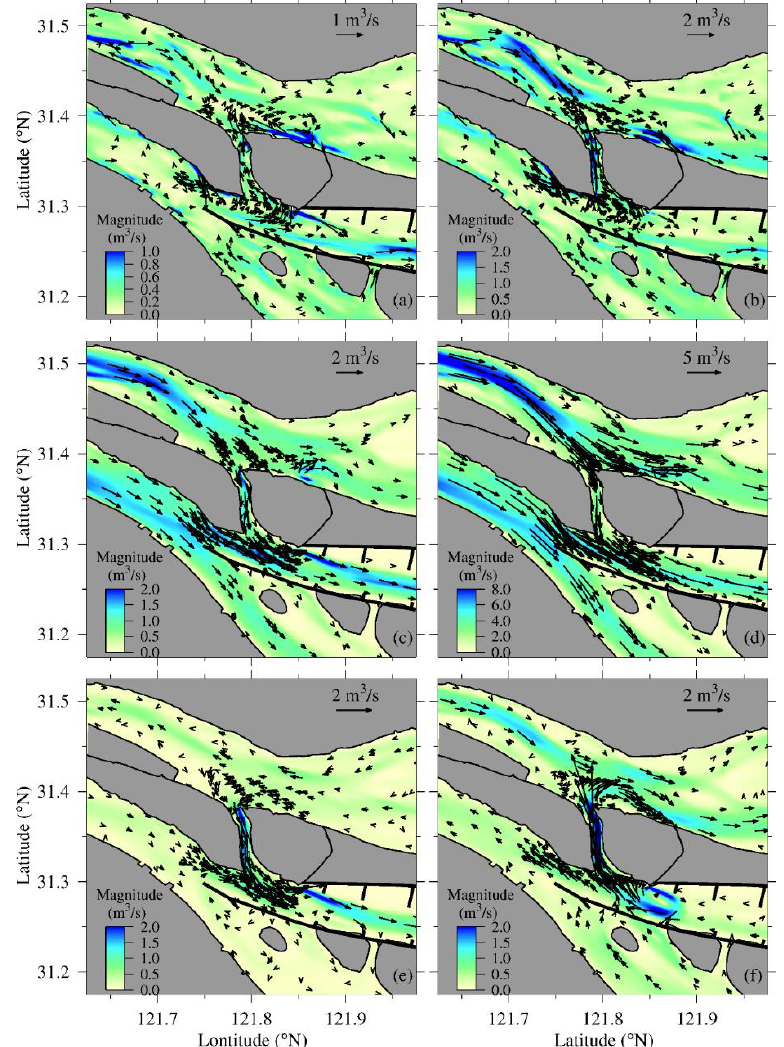
Figure 16. Residual water transport distributions during neap tide ( a ) and spring tide ( b ) in EX3 and those in EX4 ( c ), EX5 ( d ), EX6 ( e ) and EX7 ( f ).